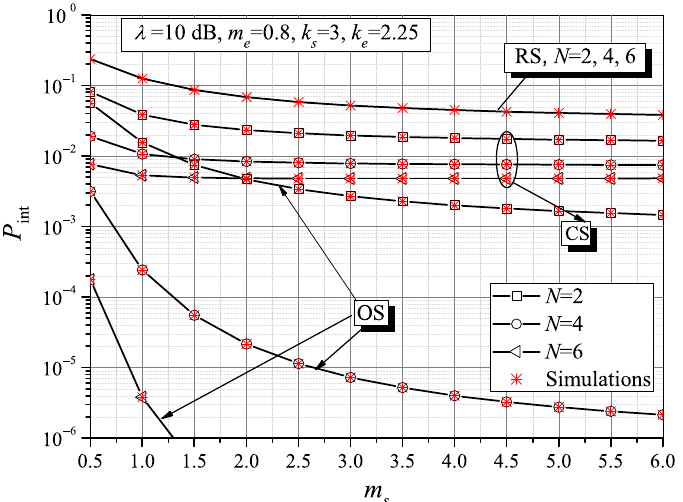
Figure 3. The intercept probability of the eavesdropped WSN vs. the fading severity over the main